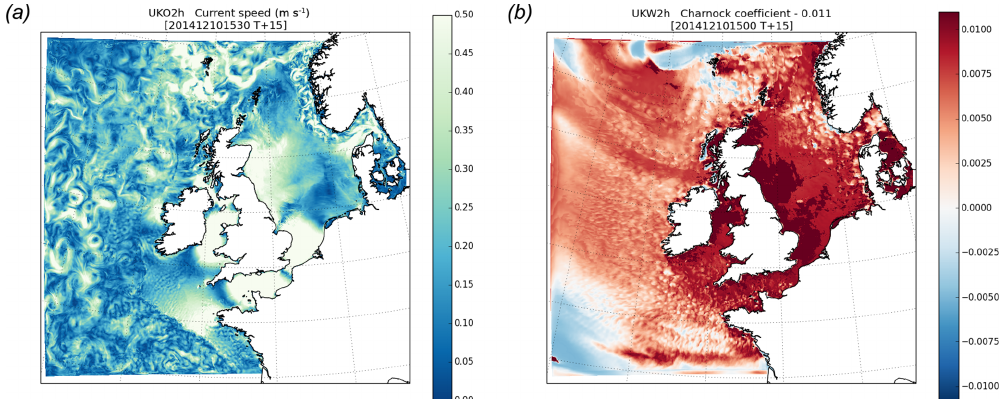
Figure 4. Sample snapshot case study output of (a) surface currents simulated by UKO2h ocean configuration and (b) Charnock parameter simulated by UKW2h wave configuration, plotted relative to the UKA2 constant value of